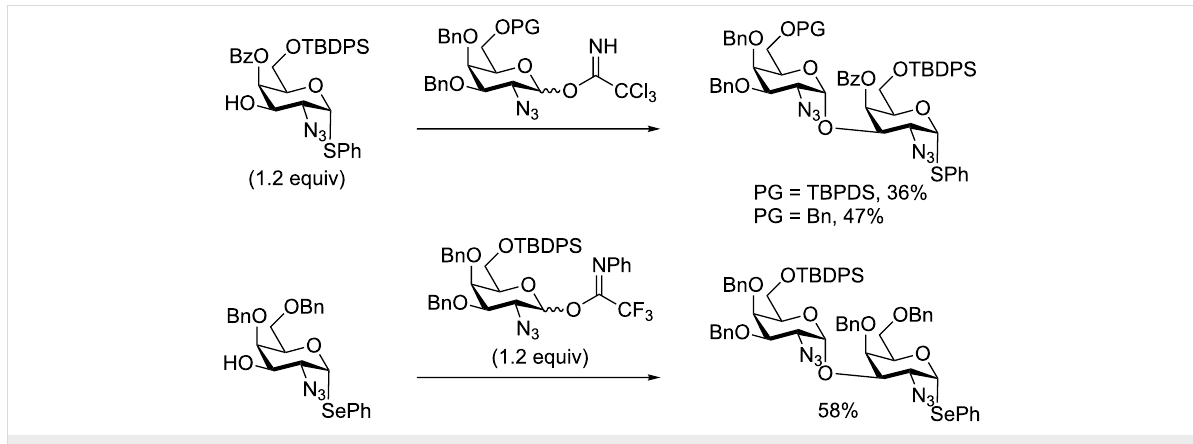
Scheme 4: Representative glycosylations with closely related systems